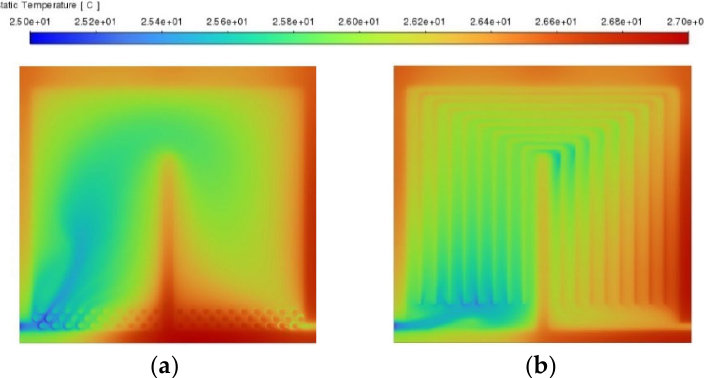
Figure 10. Battery cell surface temperature distribution for ( a ) a cooling design without channels and ( b ) a cooling design without distributors.